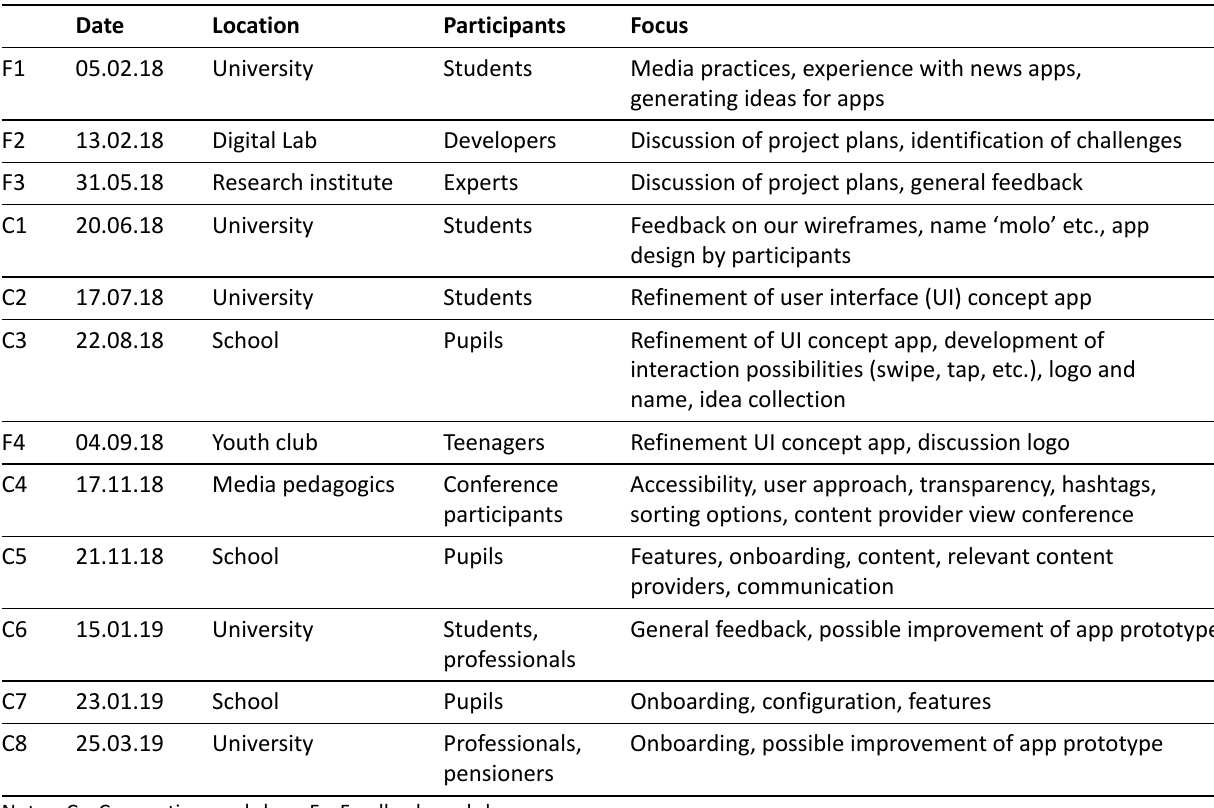
Table 1. Overview of co-creation and feedback